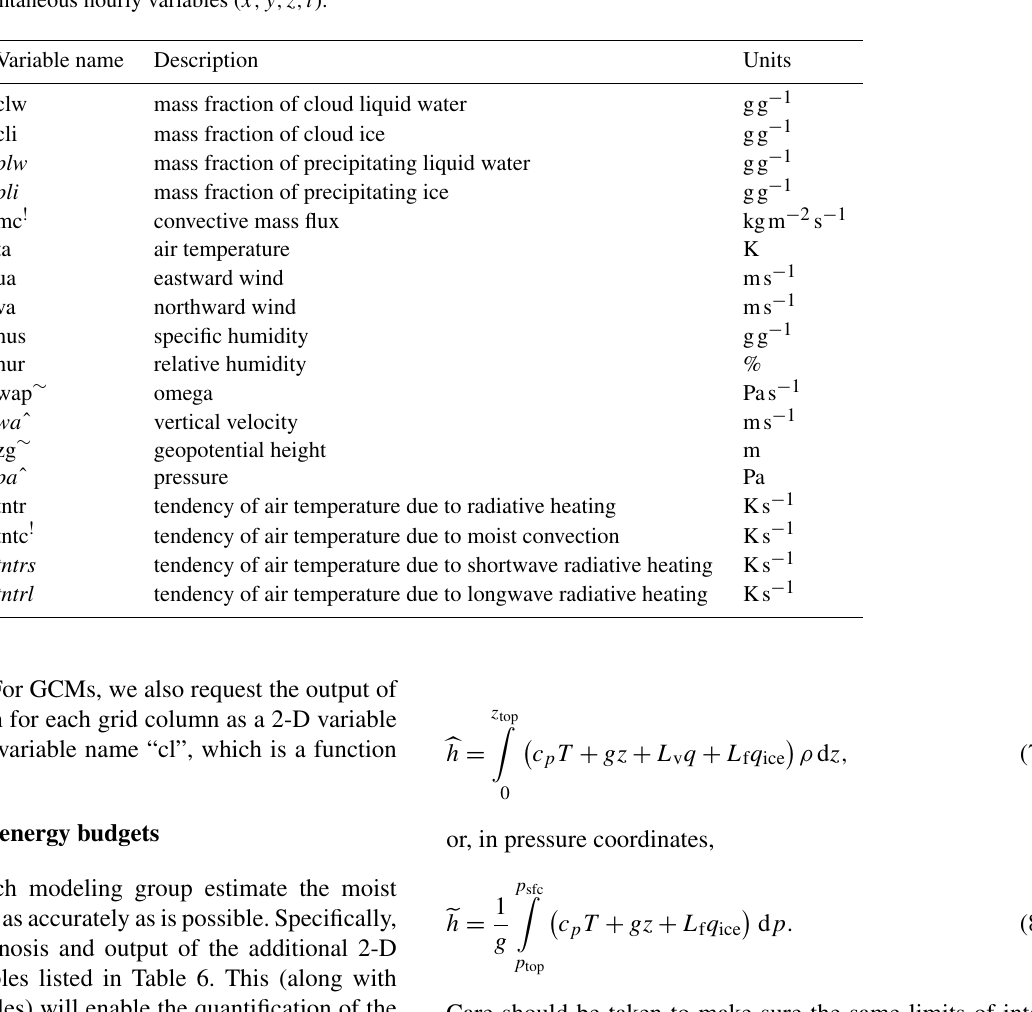
Table 7. The 3-D instantaneous hourly variables ( x,y,z,t